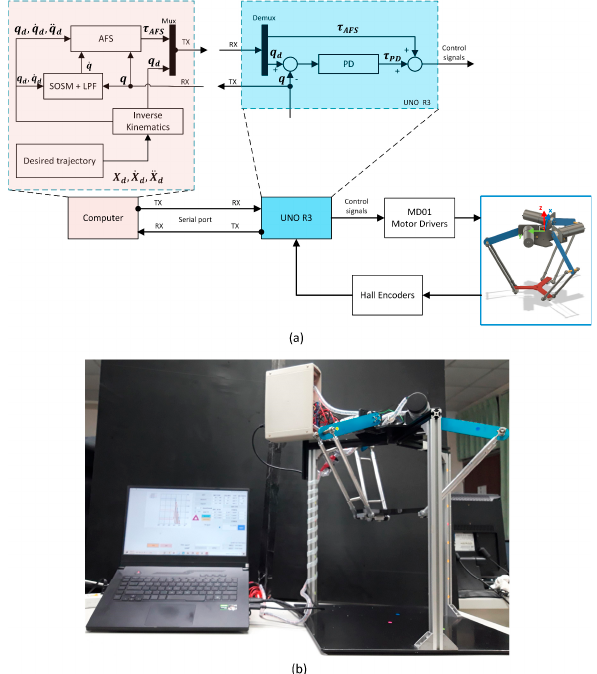
Figure 10. The measuring system diagram ( a ) and experiment setup ( b ).